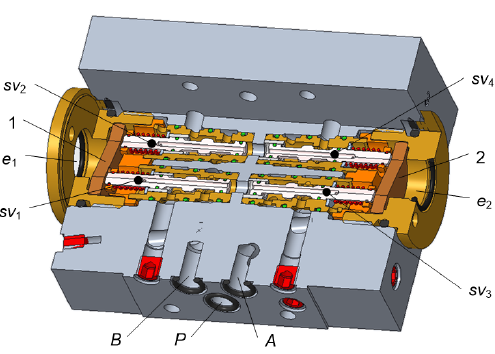
Figure 2. Valve cross-section; 1—platen, 2—cover; sv 1 . . . sv 4 —seat valve; P , A , B —hydraulic connectors.